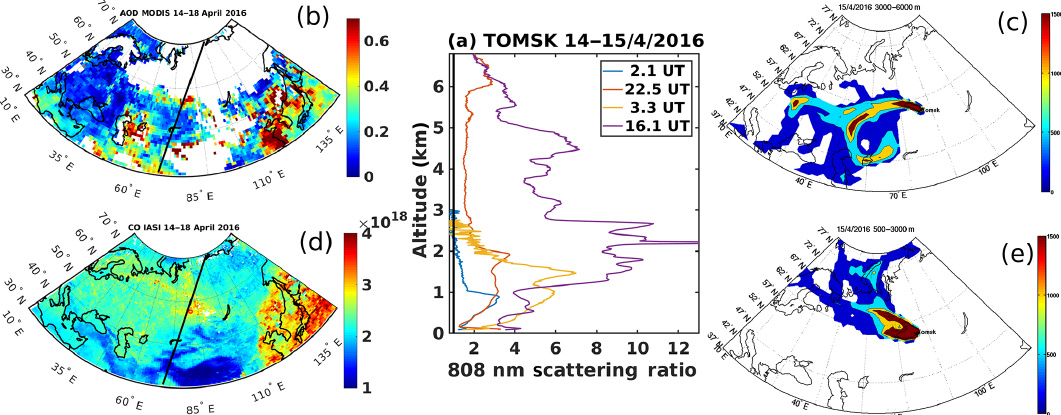
Figure 27. Vertical profiles of the scattering ratio on 14 and 15 April 2016 from Tomsk lidar (a) and the corresponding 5d average map of AOD at 532nm from MODIS (b) and of the CO total column (in molecules per square centimeter) from IASI observations (d) . The red circle is Tomsk, and the thick black lines are the CALIOP overpass over Tomsk on 14 April at 21:00UTC. Potential emission sensitivity (PES) distributions of an aerosol tracer averaged for 9d before the Tomsk lidar aerosol layer observations below 3km (e) and above 3km (c) are calculated with backward simulations of the FLEXPART model using the dry and wet deposition of the tracer during backward